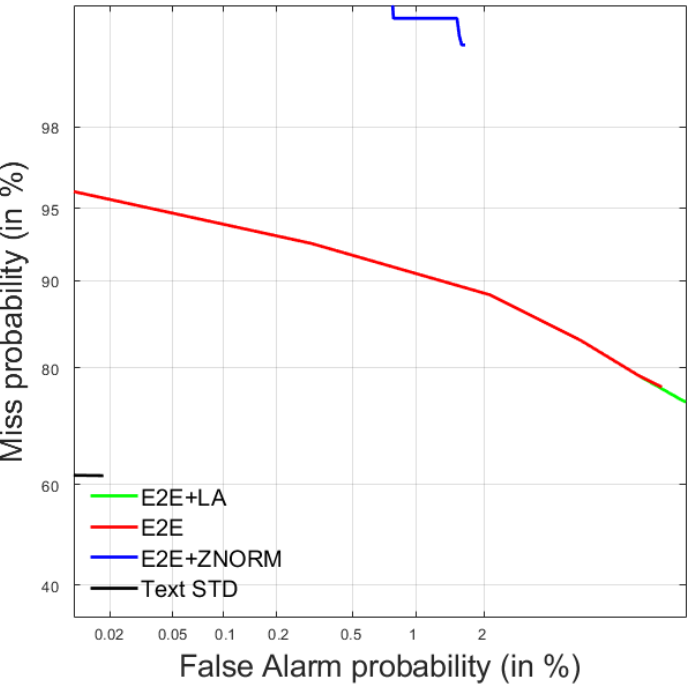
Figure 11. DET curves of the QbE STD systems and the text-based STD system for RTVE test